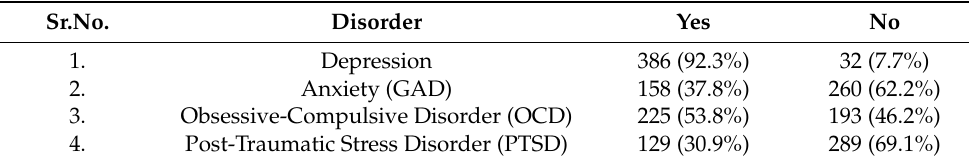
Table 2. Prevalence of psychiatric illness in the